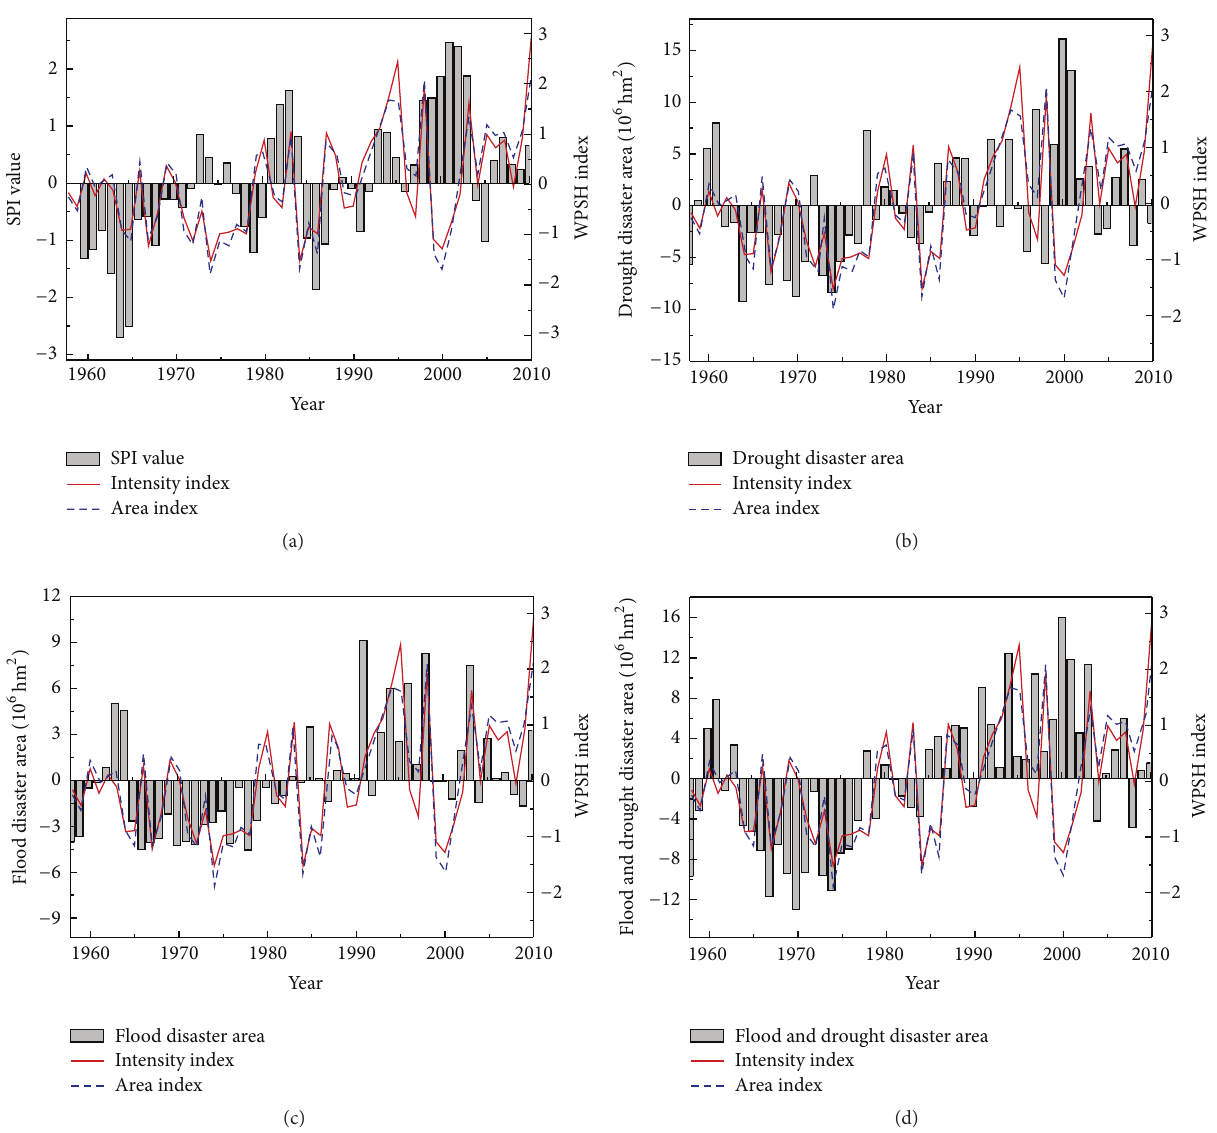
Figure 6: The variation of the SPI value, drought, and flood disaster area in China and the intensity and area index of WPSH.